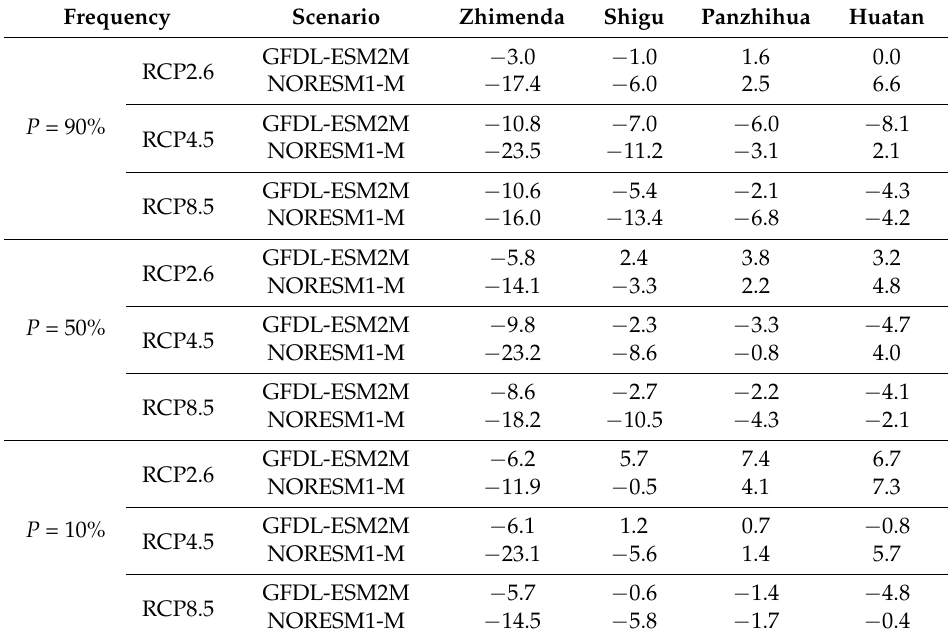
Table 4. Percentage changes (%) in streamflow under different